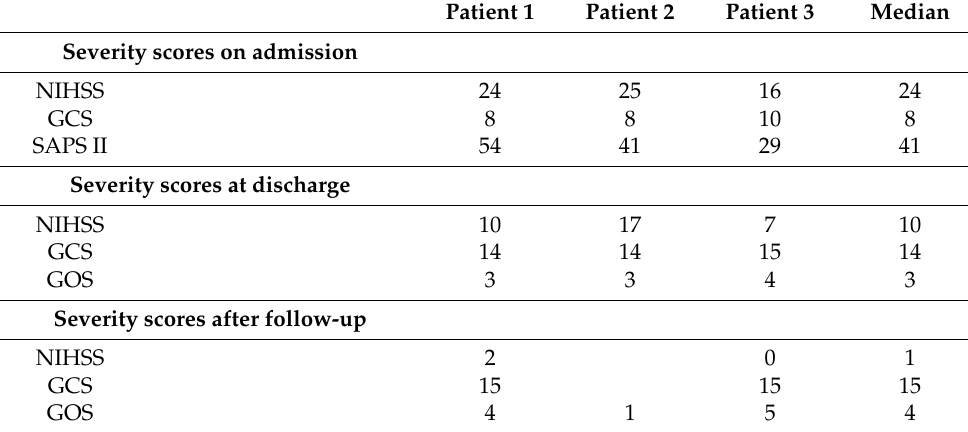
Table 2. Overview of severity scores assessed in patients with toxic hemisphere syndrome during the observation period.